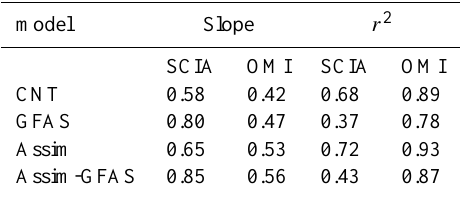
Table 10. Slope and spatial correlation ( r 2 ) of modeled tropospheric NO 2 columns for hindcast D+0 with respect to SCIAMACHY and OMI observations over western Russia between 20 July and 15 Au-